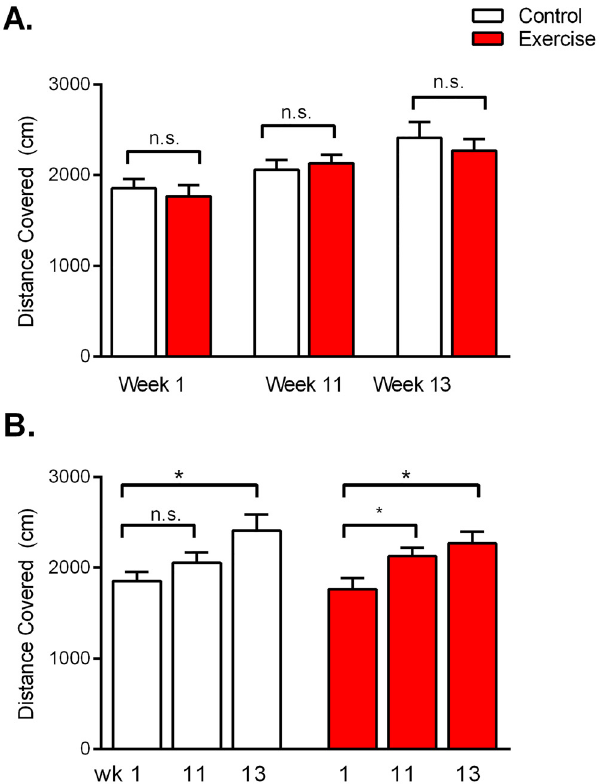
and overall assessment (ANOVA, α 0.05). B) Within group comparisons of the data in (A) revealed that each group increased its distance travelled over the course of the 13 week study. Data are shown as mean ± SEM; for each group n =